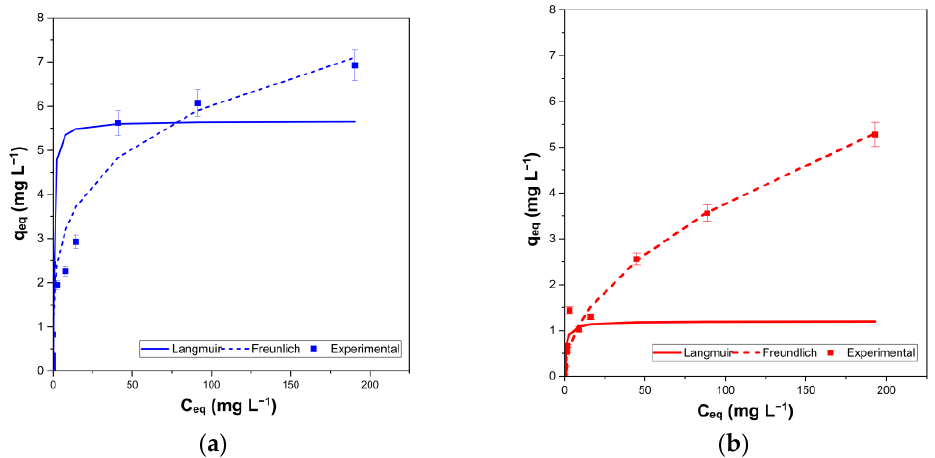
Figure 4. Adsorption isotherms for the investigated materials ( a ) NaP1_C and ( b ) NaP1_FA. Table 3. Langmuir and Freundlich models of equilibrium adsorption.